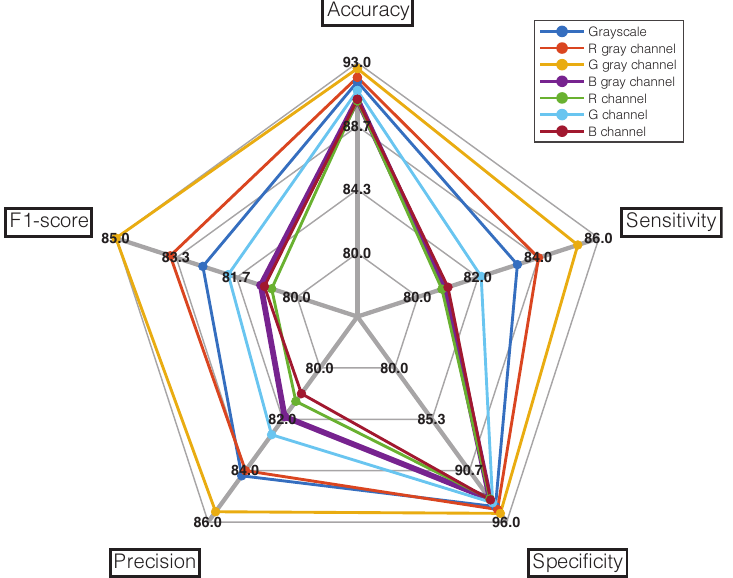
Figure 6. Radial graph showing overall performance comparison of all implemented models. The evaluation was conducted on the testing